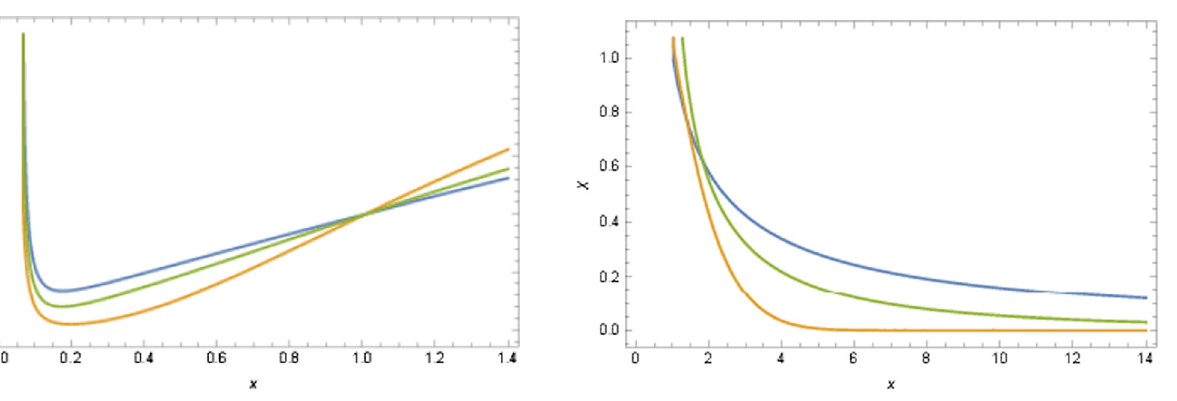
Fig. 4 Case 2. Plot χ as a function of x. For j c = 0 . 1 and a ⊥ = 1 (orange line), a ⊥ = 2 (green line) and a ⊥ = 3 (blue line)